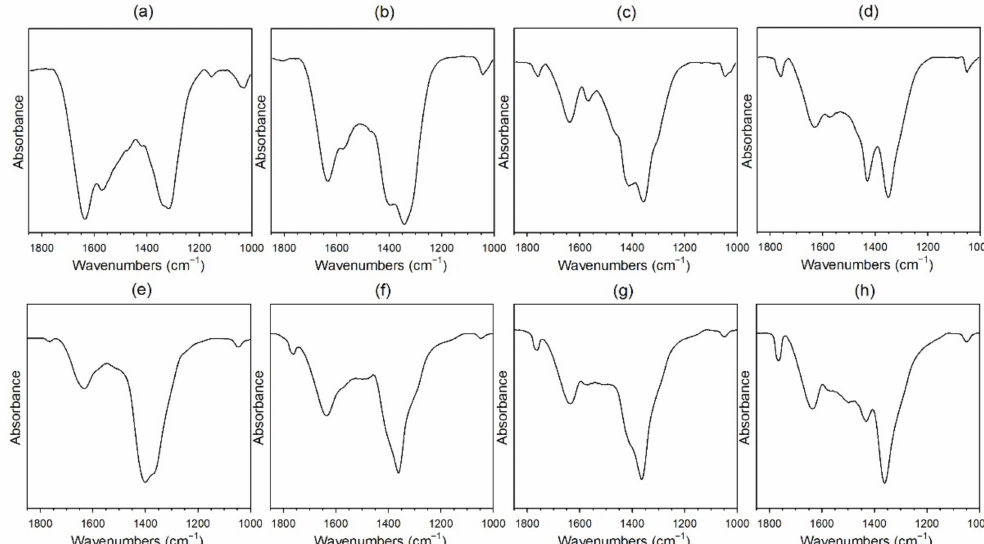
Figure 3. DRIFTS spectra of carbonate decomposition during activation for ( a ) 2% Pt/ZrO 2 , and the same doped with ( b ) 0.93% Rb, ( c ) 4.65% Rb, ( d ) 9.29% Rb, ( e ) 0.85% K, ( f ) 2.55% K, ( g ) 4.25% K, ( h ) 8.50% K. Figure 3a–d reprinted from [49] with permission from MDPI, copyright 2021. Figure 3e,f reprinted from [48] with permission from Elsevier, copyright 2020.